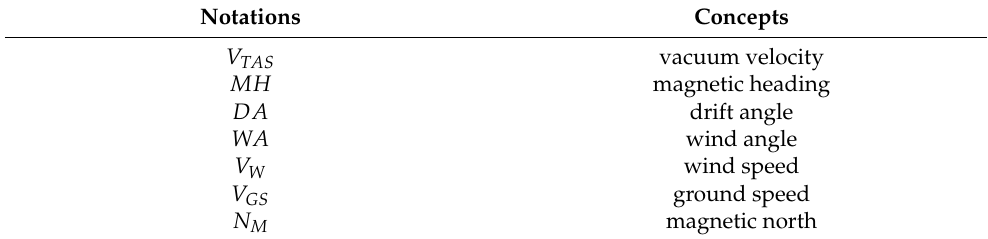
Figure 1. Aircraft speed triangle. Table 1. Notations and their corresponding concepts of Figure 1.